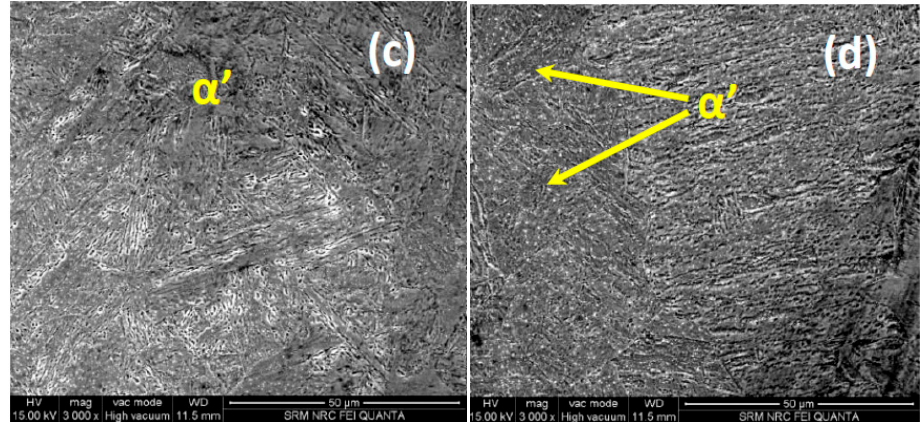
Figure 4. Scanning electron microscope (SEM) images of ( a ) EN 8 without clad; ( b ) retained austenite (lath martensite and whitish spots); ( c ) middle layer of the clad with refined grains; and ( d ) bottom layer of the clad carbon diffusion.